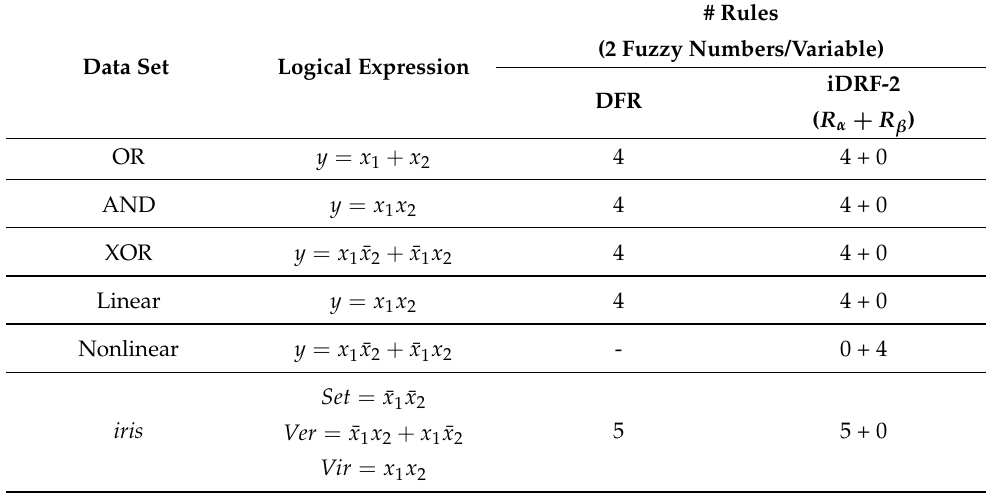
Table 7. Rules extracted by DFR and